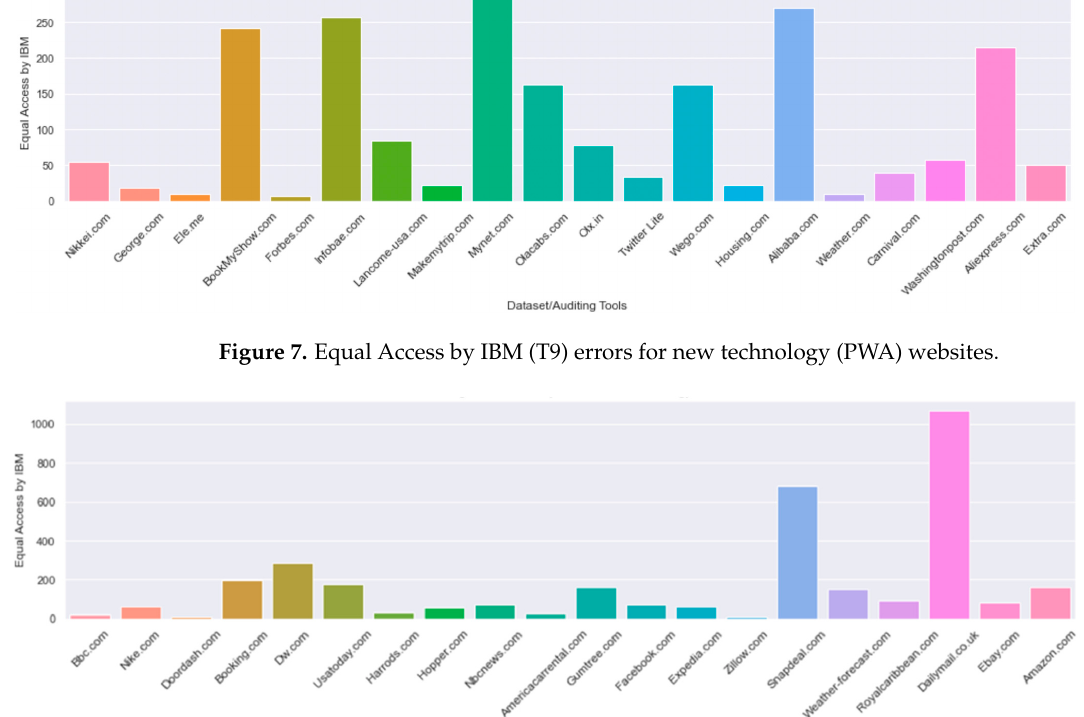
Figure 8. Equal Access by IBM (T9) errors for Older technology (non ‐ PWA) websites .